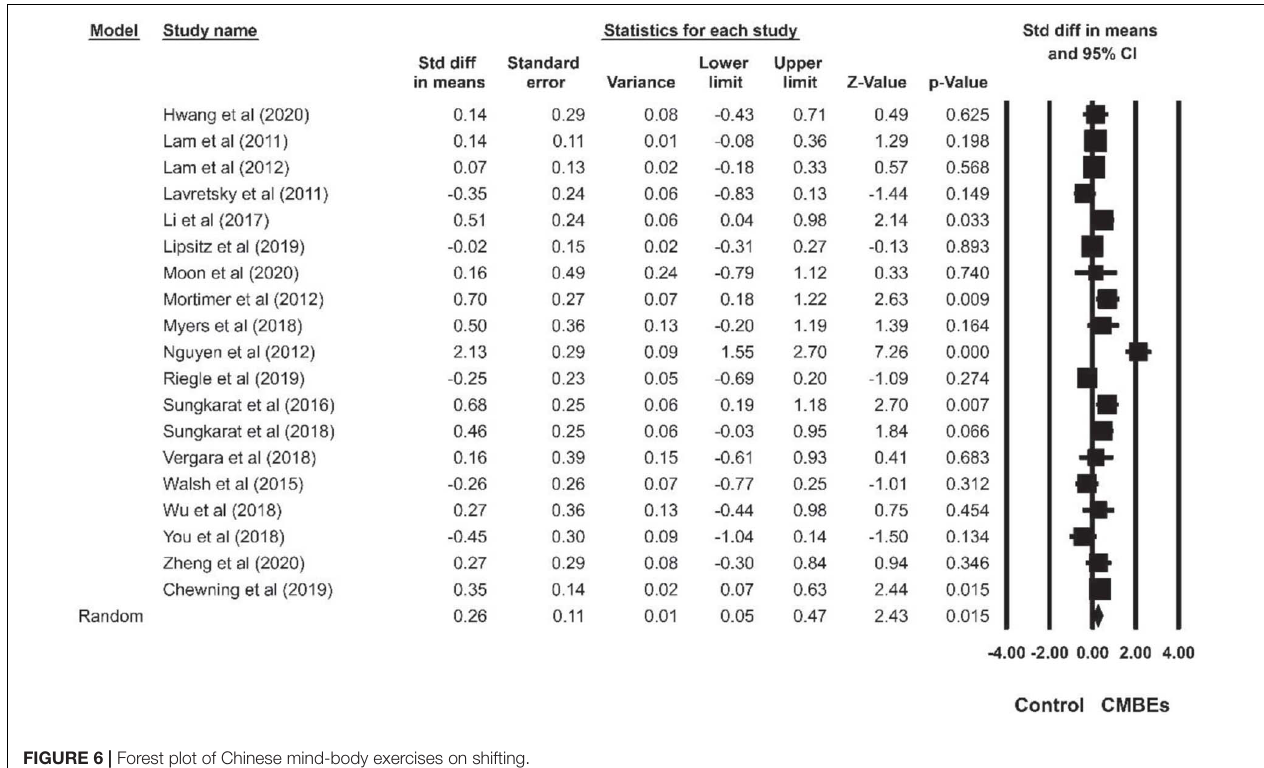
FIGURE 6 | Forest plot of Chinese mind-body exercises on shifting.